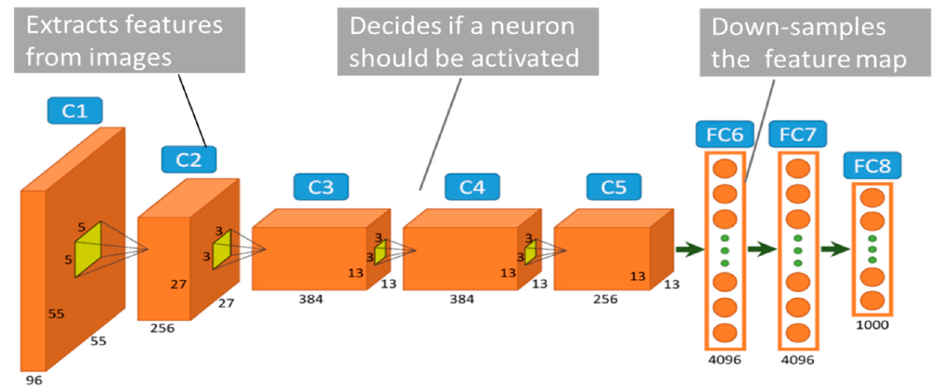
10 of 20 Figure 8. Diagram of a typical LSTM cell [38] (when data are received, input gate controls what information is stored in the long-term state, forget gate determines how long the stored information is preserved across the time instances, and lastly, the output gate controls the requested information at a particular time step) . CNNs are special types of deep neural networks that work remarkably well on image data. These models have shown breakthrough performance in especially image classifica- tion tasks (e.g., 2012 ImageNet Competition) [39]. CNN-based image analysis of infra- structure damage has been vastly studied in the past [40,41]. As shown in Figure 9, the CNN models are typically composed of convolution, activation, and pooling layers. In the